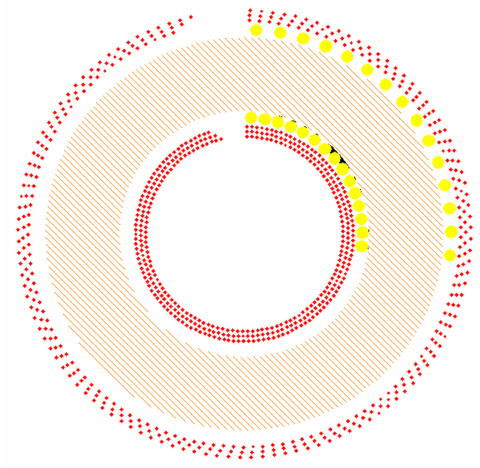
Figure 15. 2D toroidal transformer ( N P = 15 & N S =